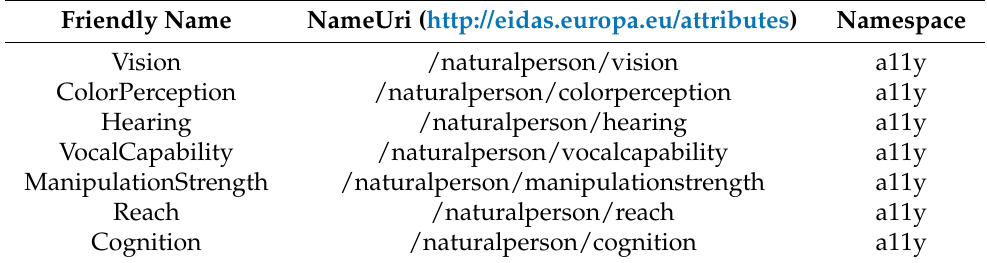
Table 3. Functional attributes proposed for extending the eIDAS